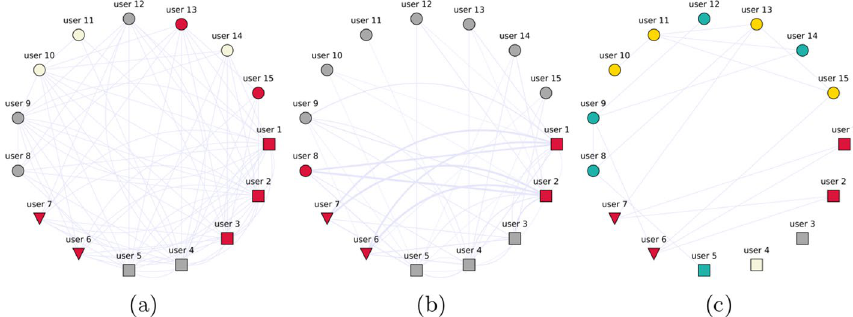
Fig. 1 Toy example: community detection results for an interaction network based on users and messages sharing the same configuration: users 6 and 7 act as spreaders for users 1 and 2 in a synthetic network. Node shape represents behaviour (square: active poster, triangle: amplifier, circle: normal user). Node colour represents community membership. a Binary retweet network. b Weighted retweet network. c Filtered projected directed bipartite